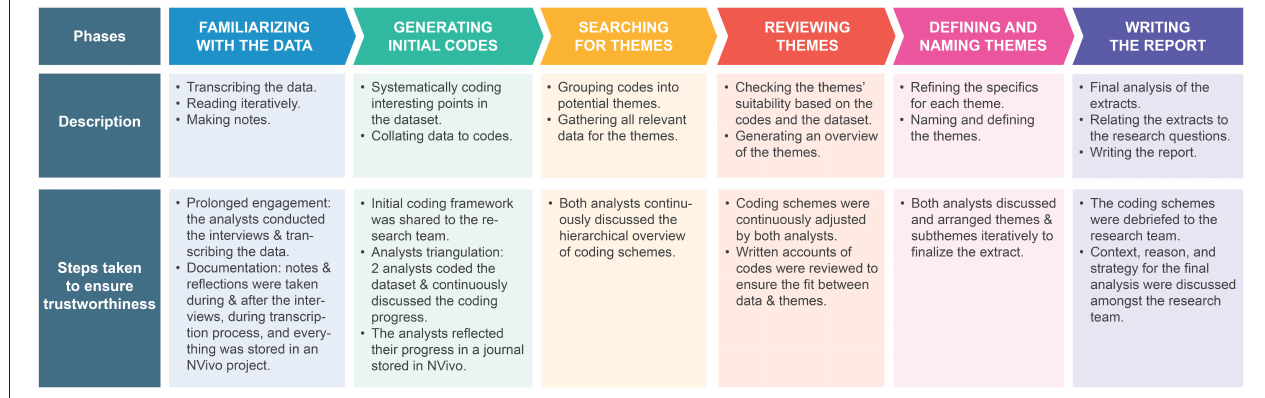
Frontiers in Psychology |